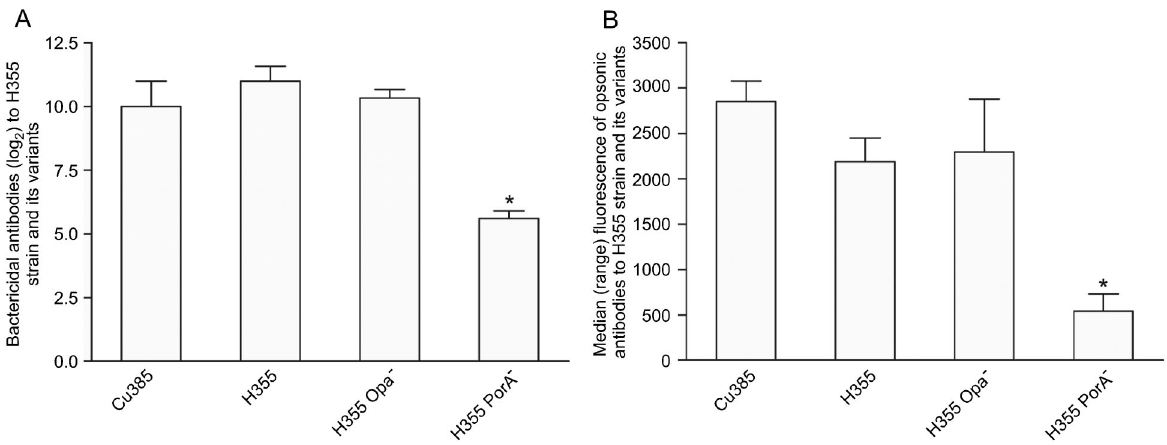
Figure 2. Bactericidal antibody titers ( A ) and opsonic antibody response measured as median fluorescence induced during the oxidative burst of neutrophils ( B ) to the vaccine strain Cu385/83, a P1.15,19 homologous strain (H355/75; B:15:P1.19,15) and its variants Opa - and PorA - . Serum samples were obtained 14 days after the third immunization. For bactericidal antibody titers ( A ), the data are the mean ± SE of three serum pools. Each pool contained serum from 3 individuals. For opsonic antibodies ( B ), the data are the median and range of values of 6 mice. *P , 0.05 (Wilcoxon matched-pair test) compared to Cu385, H355 and to H355 Opa -